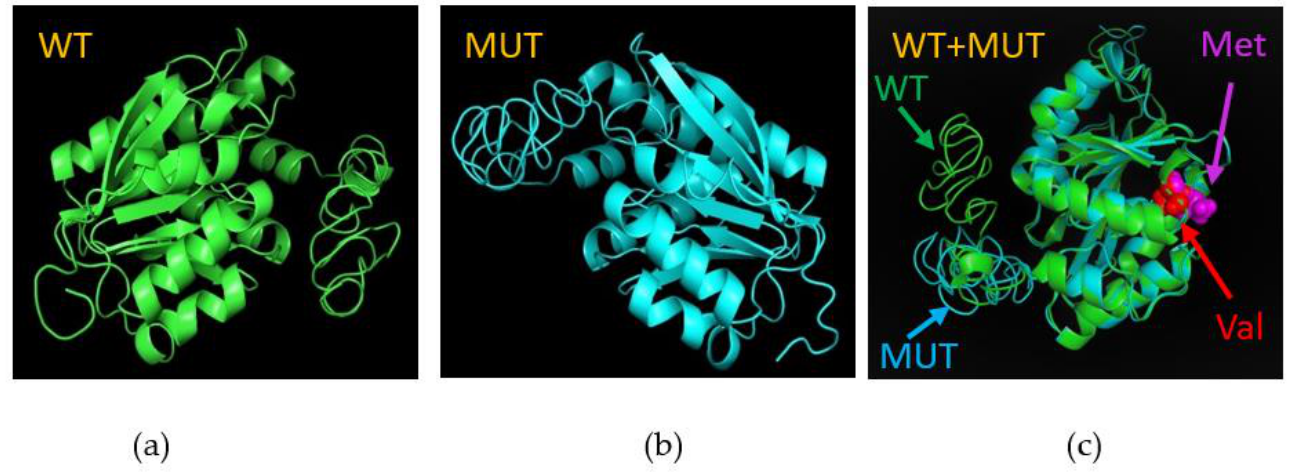
Figure 2. The wild type and mutation (rs4680) of COMT protein structure: ( a ) wild type; ( b ) mutation; ( c ) aligned WT and mutation. Abbreviations: WT: wild type; MUT: mutation; Met: methionine; Val: valine.